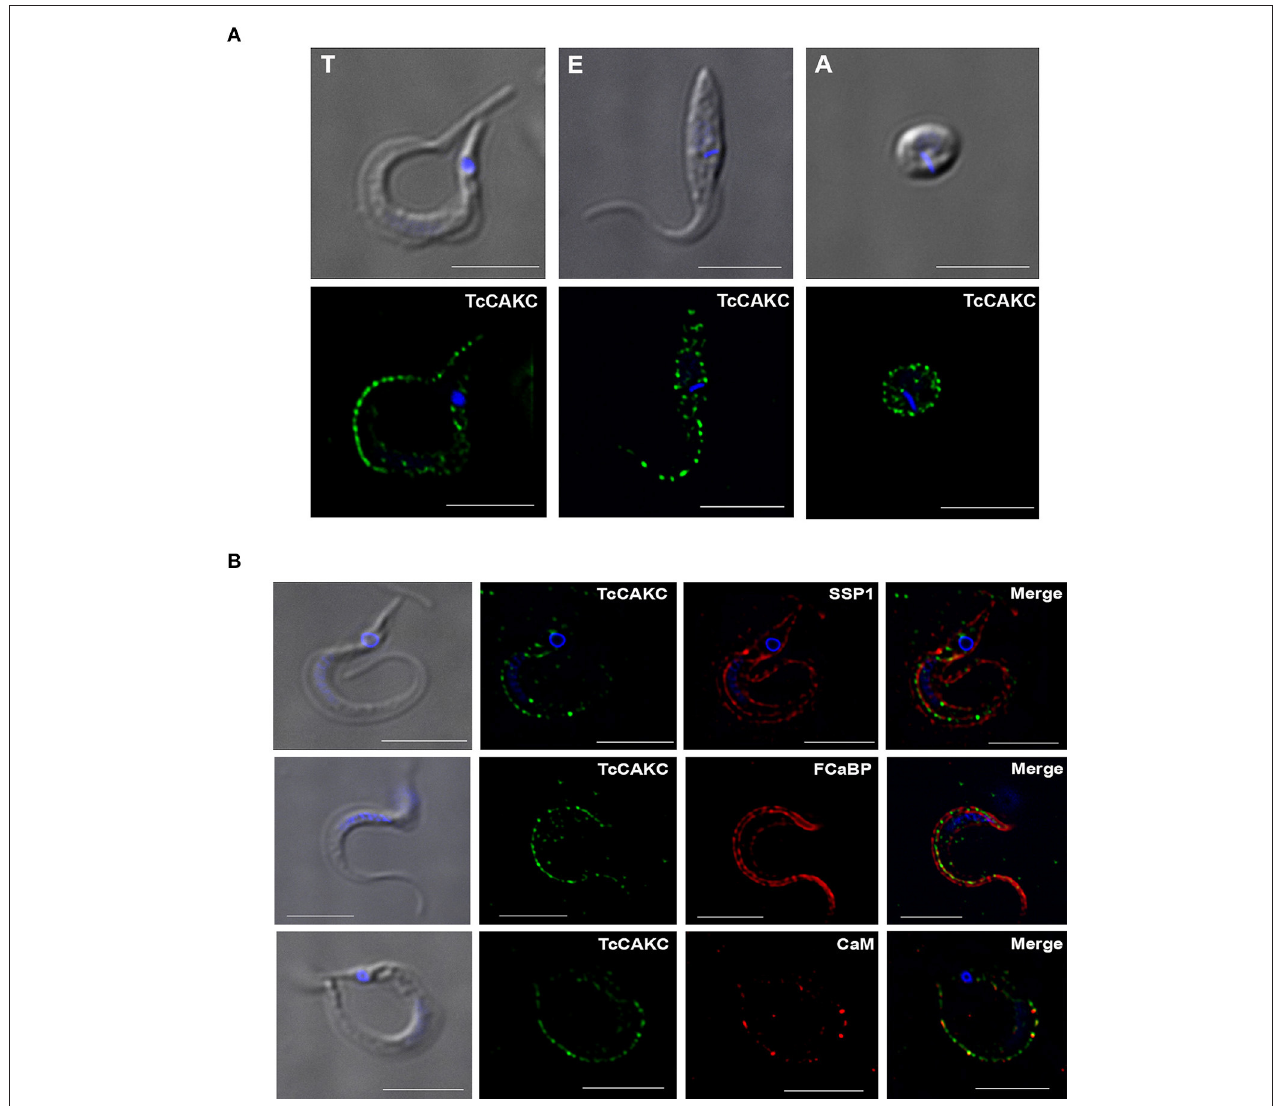
FIGURE 1 | TcCAKC localization. (A) Immunofluorescence analysis of T. cruzi trypomastigotes (T), epimastigotes (E), and amastigotes (A) with polyclonal antibodies against the channel (green). (B) Trypomastigotes immunofluorescence showing TcCAKC (green) colocalization with membrane marker SSP-1 (red), and calcium binding proteins FCaBP and calmodulin. Nuclei and kinetoplasts were DAPI stained. Bar size: 10 µ